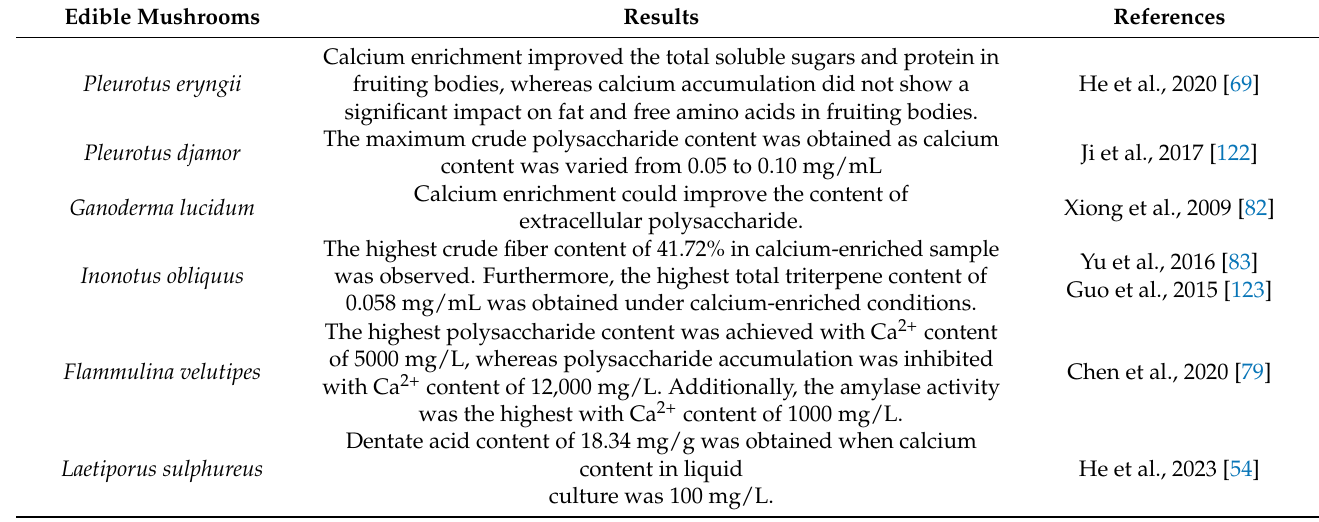
Table 3. Effect of calcium enrichment on nutritive value of edible